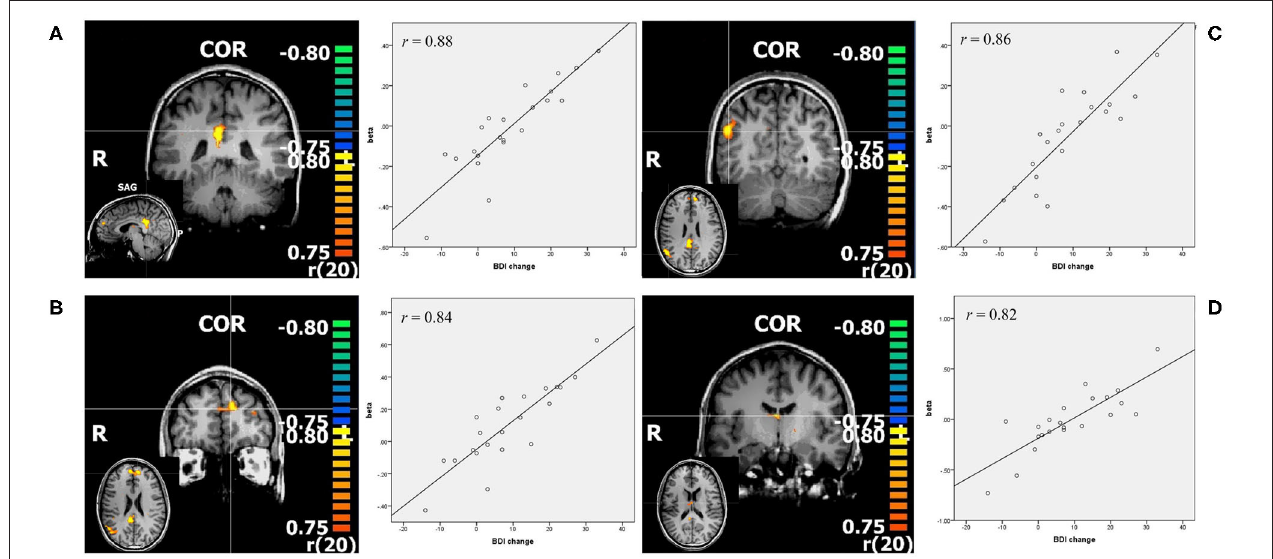
FIGURE 2 | Resulting regions of correlation analysis with change in BDI in contrast positive > neutral. The color bars represent r values, p < 0.00005. (A) PCC: posterior cingulate cortex; (B) mFG: middle frontal gyrus; (C) mTG: middle temporal gyrus; (D) thalamus, all shown in coronal slice, with sagittal or transverse slice shown in small. Additionally scatterplots of the depicted regions beta values and change in BDI are shown, as well as r = Pearson’s correlation coefficient.